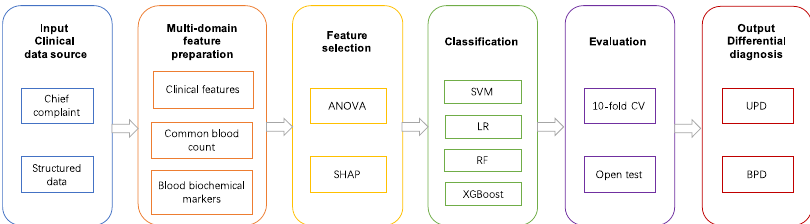
Fig. 2 Study design of classi fi cation-based differential diagnosis between unipolar and bipolar depression. Features of three domains were fi rst extracted from clinical data sources of chief complaints and structured tables. Then, two feature selection algorithms, ANOVA and SHAP, were adopted to select the most informative features. After that, four classi fi cation algorithms were used for differential diagnosis including support vector machine (SVM), logistic regression (LR), random forest (RF), and Extreme Gradient Boosting (XGBoost) methods. Models were trained using 10-fold cross-validation and further evaluated on the open-test dataset.